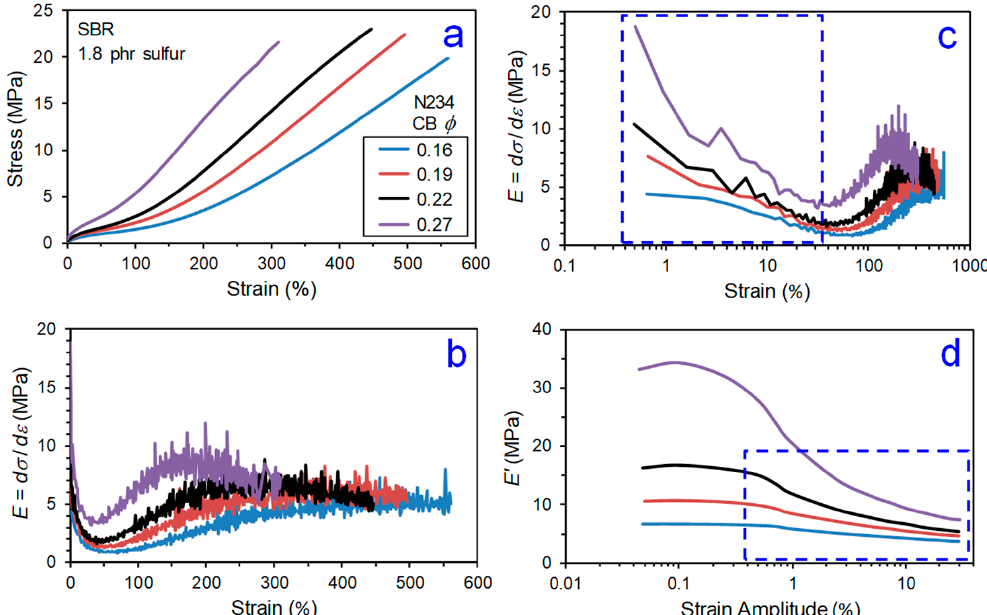
Figure 6. Effect of CB loading on tensile stress versus strain behavior at 23 °C ( a ) and its derivative (slope; modulus ( E )) for CB-filled SBR plotted versus linear strain ( b ) and logarithmic strain ( c ). Unitless strain (not %) used when determining E . Also shown is strain amplitude dependence of dynamic storage modulus ( E’ ) at 60 °C and 10 Hz ( d ). Each blue dashed-line box has the same dimensions in both ( c ) and ( d ) to allow comparisons of the strain-induced softening (Payne effect). Results are replotted from Warasitthinon and Robertson [11].